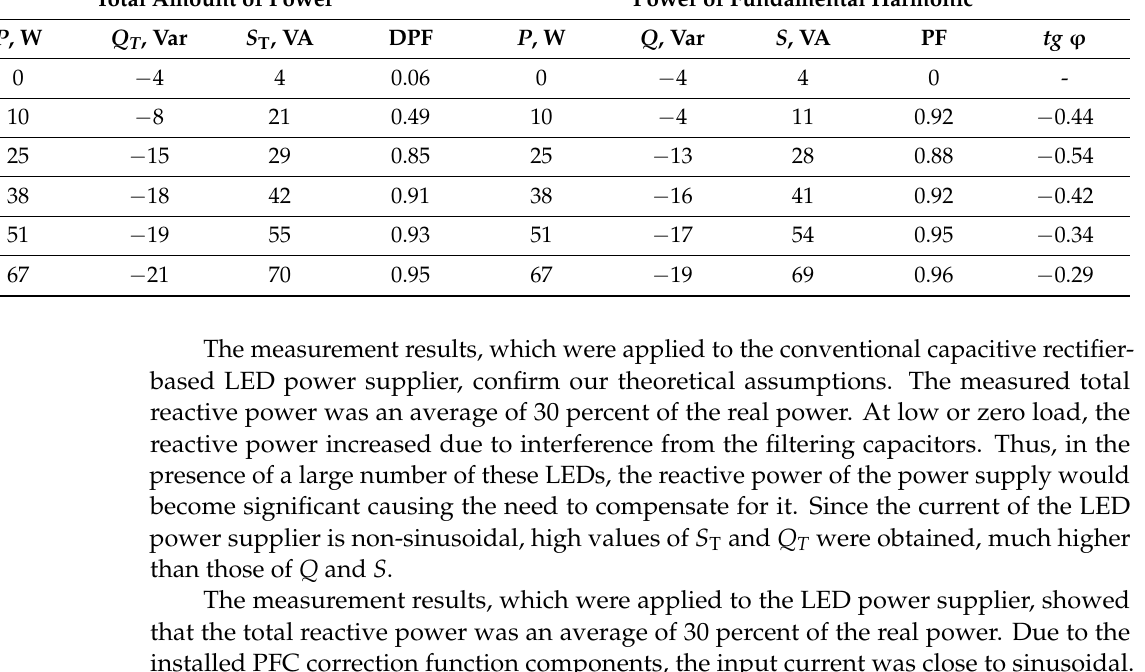
Table 2. Measurement results for the LED power supplier with the PFC correction function. Load, A